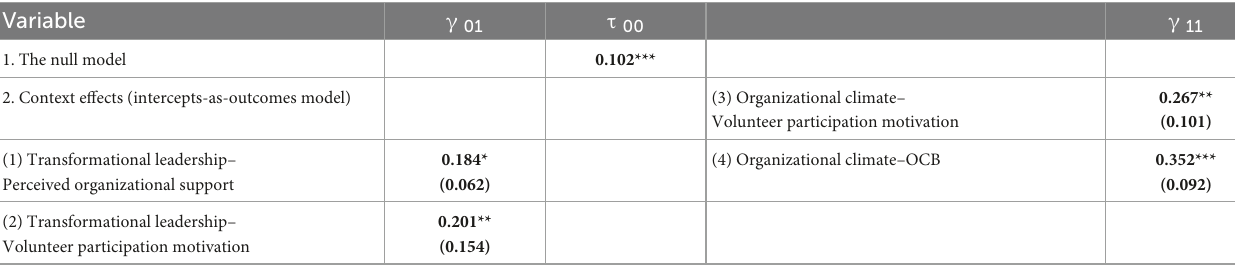
TABLE 4 Hierarchical Linear Modeling Results for Individual variables.